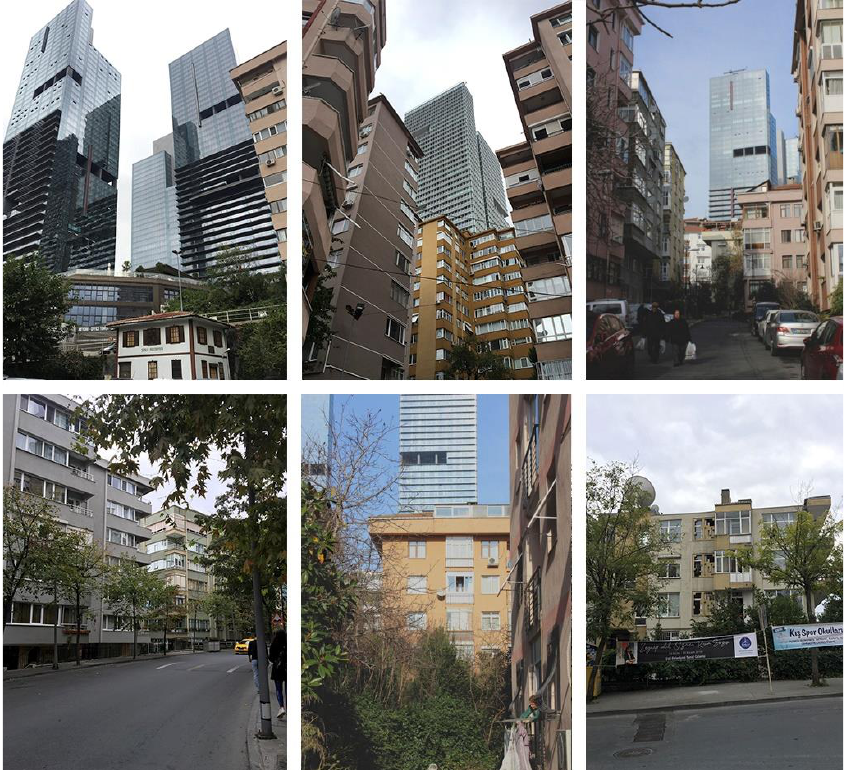
Figure 8 Residential settlements in Mecidiyeköy (Photograph credits: personal archive of Feride Gül Keleş, 2019 and Url -